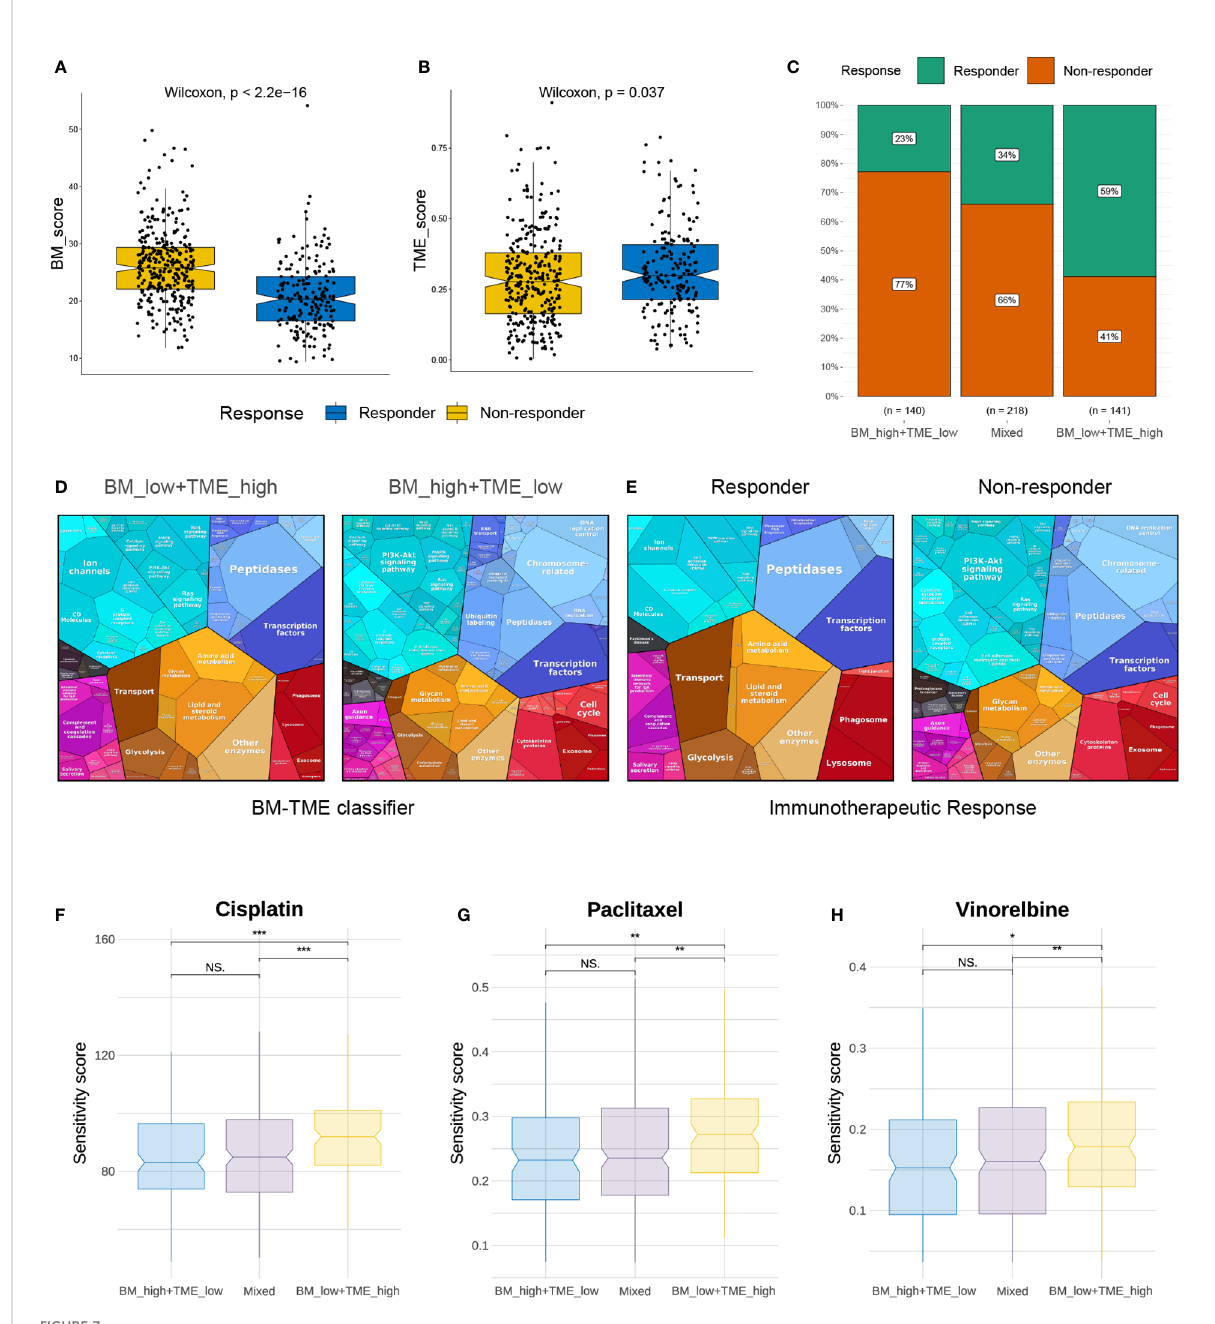
FIGURE 7 Immunotherapy response and chemotherapy drug screening prediction. (A, B) Differential distribution of BM score and TME score in immunotherapy response and non-response groups. (C) Comparison of immunotherapy responses among different BM-TME classi fi er groups in TCGA-LUAD cohort. (D, E) Proteomaps of the functional analysis results in patients of “ BM_low+TME_high ” , “ BM_high+TME_low ” , immunotherapy responder and non-responder groups. Each KEGG pathway is represented by a polygon, and the size of polygons corresponds to the protein ratio. (F – H) Comparison of drug sensitivity to cisplatin, paclitaxel and vinorelbine among different BM-TME subgroups. *p<=0.05, **p<=0.01 and ***p<=0.001, respectively. ns, no signi fi